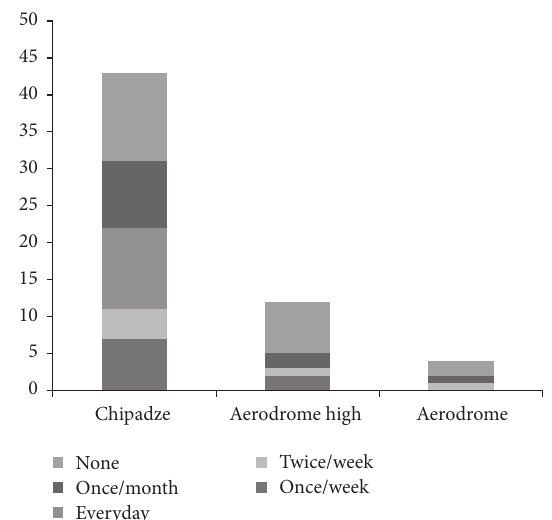
Figure 3: Frequency of eating D. steriscus for Bindura high density residents ( 𝑁 = 60 ).